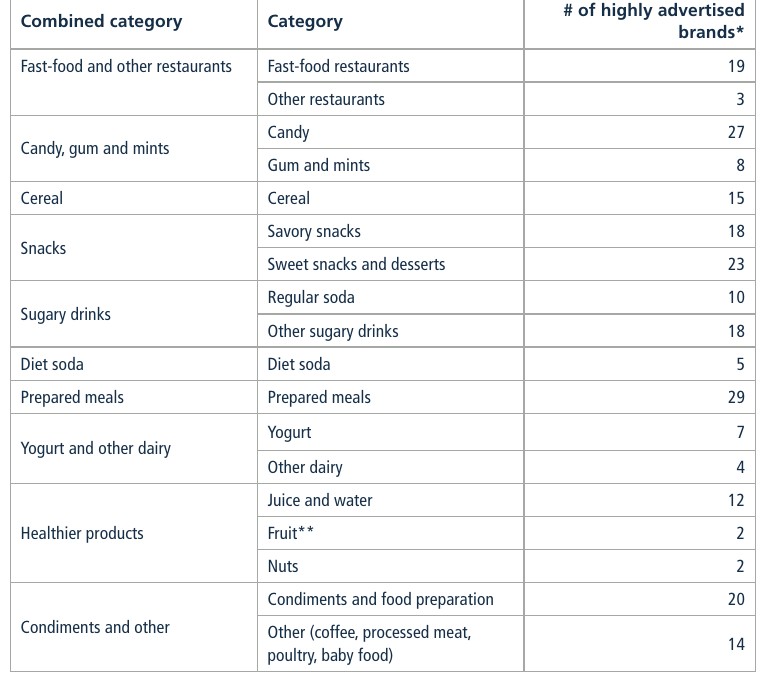
TABLE 2. HIGHLY ADVERTISED BRANDS* BY PRODUCT